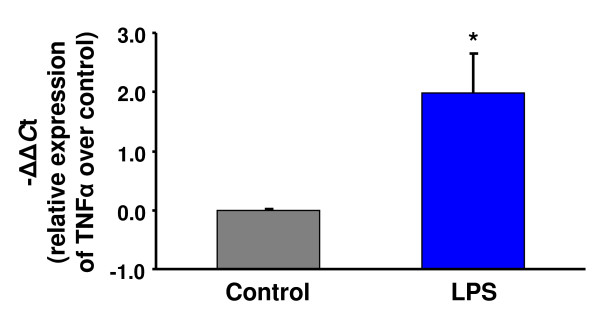
Expression of tumor necrosis factor α (TNFα) in the brook trout ovary in response to lipopolysaccharide (LPS) administration in vivo. The relative expression of TNFα was determined by real-time PCR (qPCR) and normalized to the abundance of 18S. The results from ovarian tissue from 3 separate brook trout females for each group are expressed as mean -ΔΔCt ± SE (n = 3) with respect to the control, which has been set at 0. Statistically significant (p < 0.05) differences with respect to the control group are indicated by an asterisk (*).